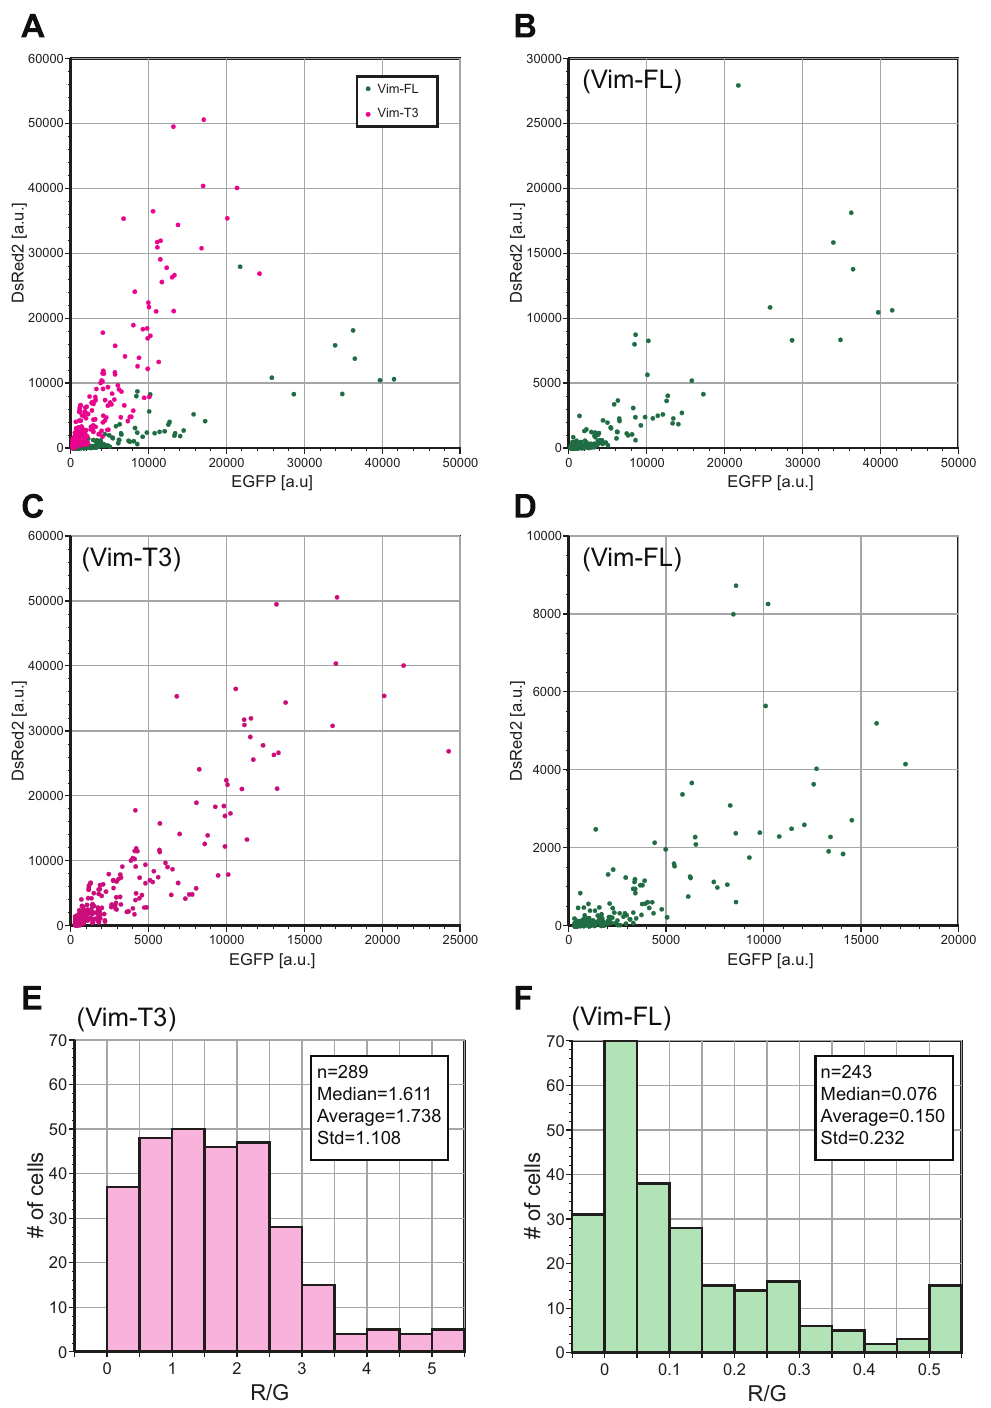
Supplemental Figure 5. Comparison between full length cDNA and 19-nt in the dual fluorescence assay. Rat2 cells were transfected with either pSHIN-G plus pREFLECT-R(DsR)-Vim-T3 or pSHIN-G plus pREFLECT-R(DsR)-Vim-FL containing the full length coding sequence of human vimentin. Plasmids were mixed at the weight ratio of 1:4. Two days after, cells were imaged and analyzed as in Figure 2. ( A ) Scatter plot of the Vim-T3 and Vim-FL transfectants. The DsRed2 fluorescence of Vim-FL was lower than that of Vim-T3. ( B & D ) Scatter plots of the Vim-FL transfectants at different scales. ( C ) Scatter plot of Vim-T3. The correlation between green and red fluorescence of the Vim-T3 transfectants was better than that of the Vim-FL ones. ( E & F ) Histograms of the R/G ratios of Vim-T3 and Vim-FL, respectively. Note that some EGFP-expressing transfectants did not show red fluorescence, resulting in negative R/G ratios in the Vim-FL samples. The standard deviation (Std) relative to the average of the Vim-FL is greater than that of